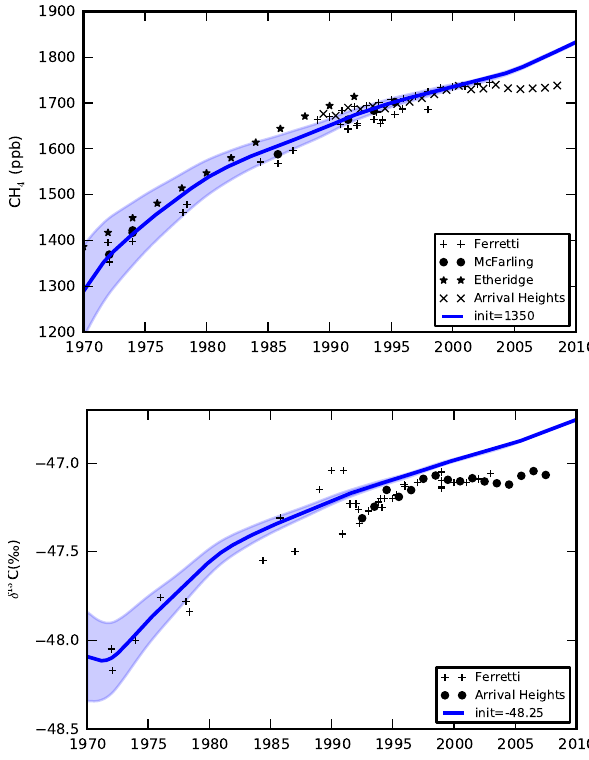
Fig. 1. Comparison between model base scenario and measure- ments from ice-cores, firn by Etheridge et al. (1998),Ferretti et al. (2005) and MacFarling Meure et al. (2006), and yearly averaged atmospheric measurements at Arrival Heights for CH 4 and δ 13 C- CH 4 . Solid blue line corresponds to simulations using mean initial values of 1350ppb for CH 4 and − 48.25‰ for δ 13 C-CH 4 . Shaded areas represent uncertainty ranges of ± 100ppb for methane and ± 0 . 5‰ for δ 13 C-CH 4